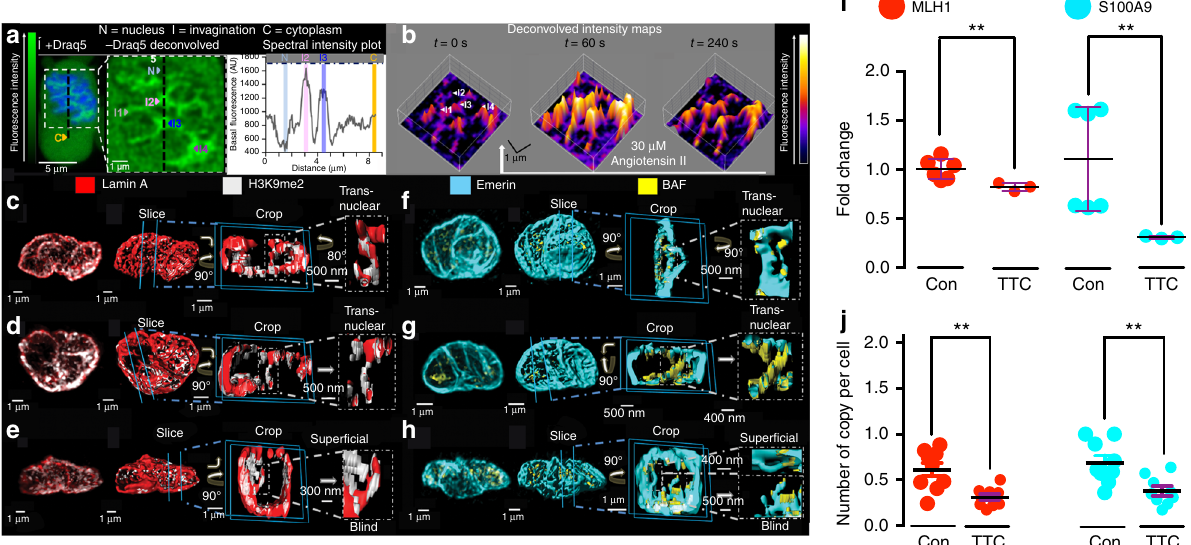
Fig. 5 Ca 2 + fl ux into nuclear invaginations regulates gene expression. a (from left to right) Confocal z section of Fluo-4 fl uorescence in an arterial myocyte (green) ± nuclear label (blue, Draq5), indicating perinuclear cytoplasm (C), nuclear invaginations (I1, I2, I3, I4) and nucleoplasm (N), and fl uorescence intensity plot along vertical dashed black line marked in images. b Time series of 3D intensity maps for nuclear region of cell in ( a ) during application of Angiotensin II (30 μ M, white arrow). c (from left to right) 3D reconstruction of section through the nucleus of a myocyte labelled for lamin A (red; con fi rmed in 54 cells from 14 rats) and showing co-localisation with H3K9me2 (white; con fi rmed in 14 cells from 5 rats), then same image with digital skin, sectioned and rotated to identify a transnuclear invagination. d , e As in ( c ) but different cells. f – h As in ( c – e ), but showing BAF co-localisation with emerin; con fi rmed in 10 cells from 4 rats. i , j Dot plots show (mean ± SEM) the effect of blocking RyRs with tetracaine (TTC, 1 mM, 90 min pre-incubation) on MLH1 and S100A9 expression in acutely isolated pulmonary arterial myocytes, assessed by i q-RT-PCR (assayed in triplicate, for n = 3 rats) and j RNAscope (counts per cell, 14 – 57 cells per plate, n = 9 independent experiments from 3 rats); t -test with Welch ’ s correction: ** p < 0.01. The green and pseudocolour look up tables in ( a ) and ( b ) indicate relative fl uorescence intensity in arbitrary